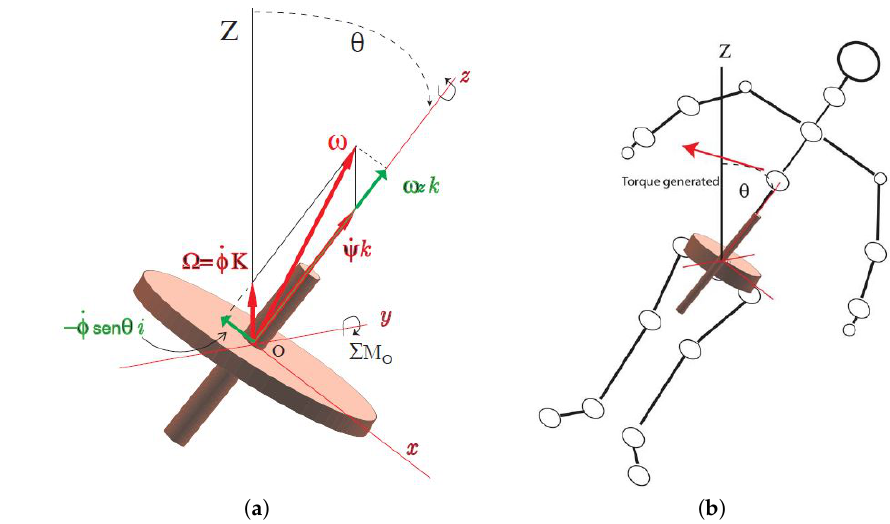
Figure 3. Gyroscope: ( a ) Central section, axis, Euler angles. ( b ) Torque produced in gyroscope and regulated angle ( θ